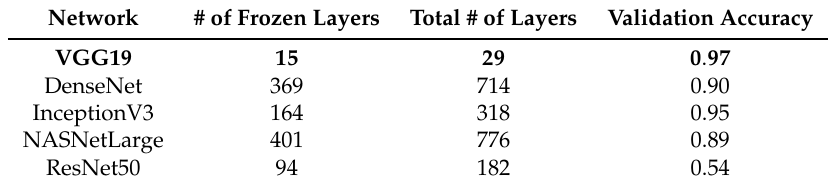
Table 7. Results on medium logo detection, using different architectures. The best choice of network and frozen layers in terms of validation accuracy is highlighted in boldface font.